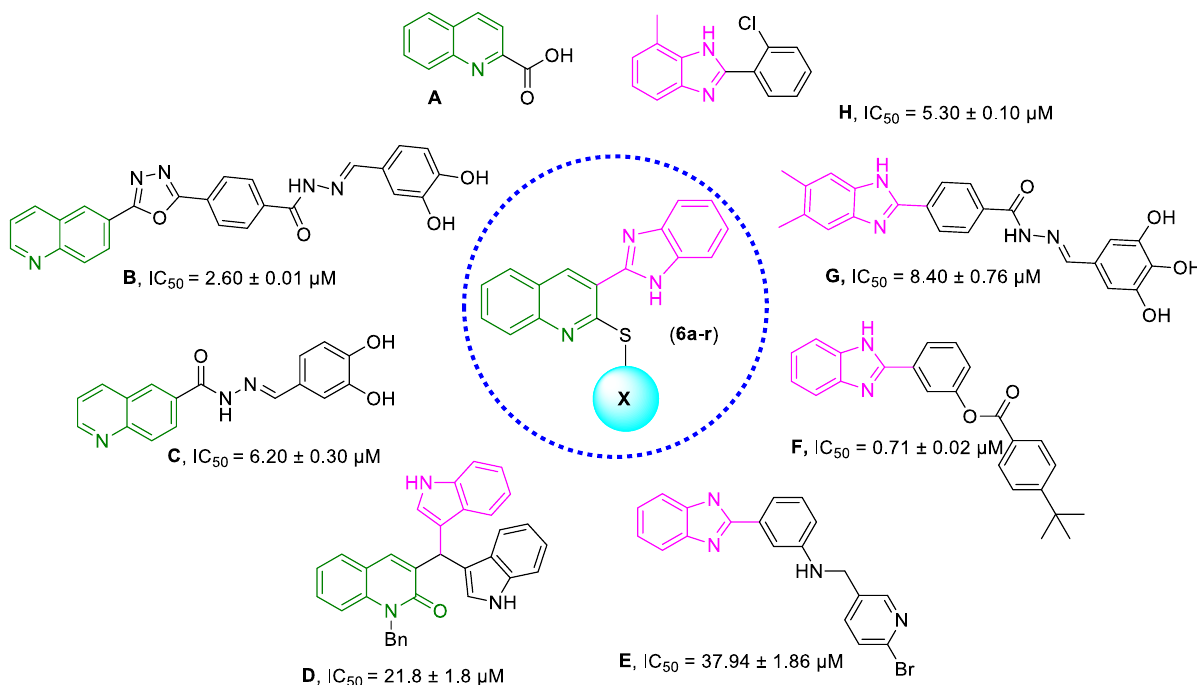
Figure 1. Design of novel α-glucosidase inhibitors ( 6a–r